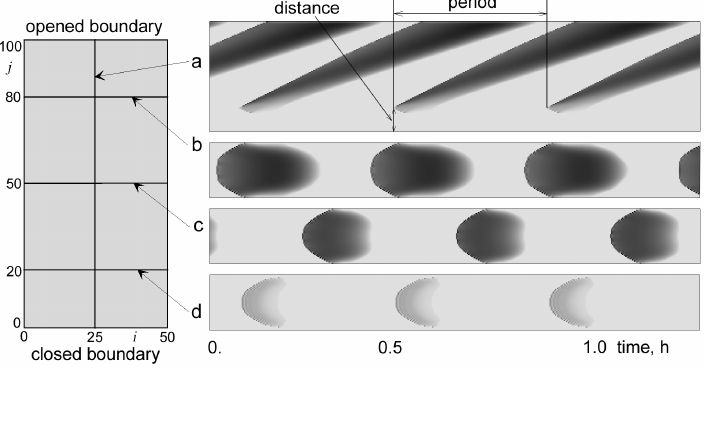
Fig. 3. Keograms of transients in periodical regime at B z = − 3nT. Cross sections of E t (i,j) array used for keograms shown in left panel.